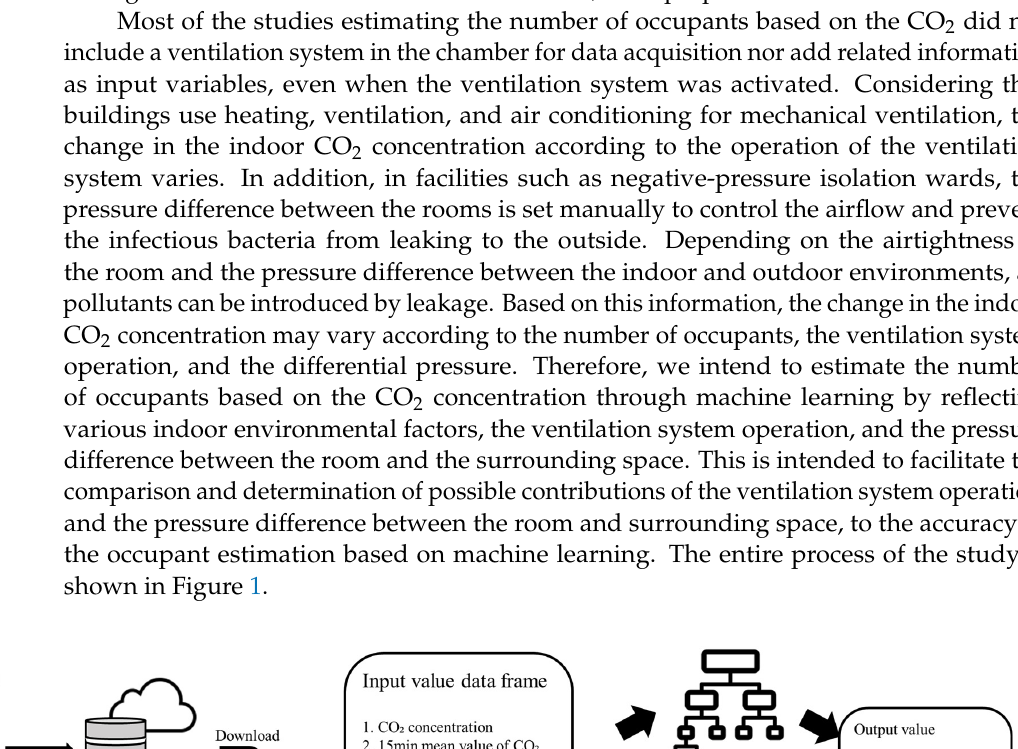
Figure 2. The concept of data mining and sensor configuration. Table 2. The Internet of Things sensor specification. CO ₂